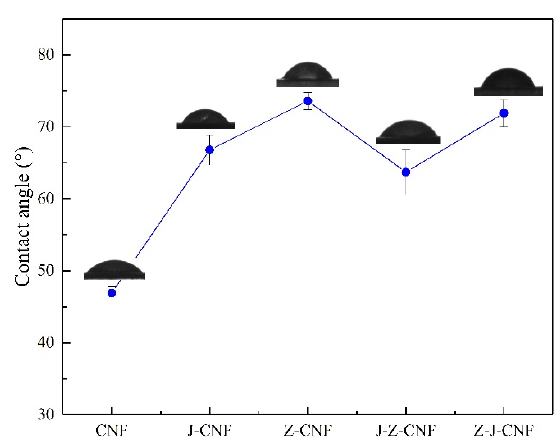
Figure 7. Contact angles of the CNF and modified CNF.